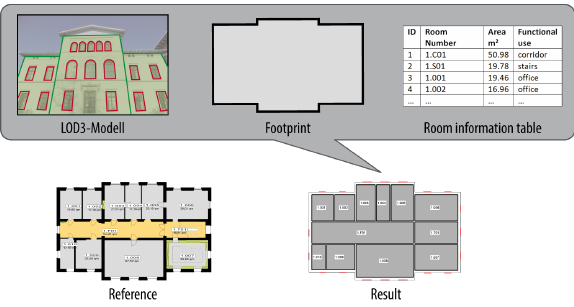
Figure 4: Automatic derivation of floor plans (bottom right) from sparse observations like window locations from possibly LoD3 exterior models, footprint and room information such as room areas (top). No additional indoor measurements are needed. For the comparison, a reference floor plan is depicted (bottom left). (Loch-Dehbi et al., 2017)